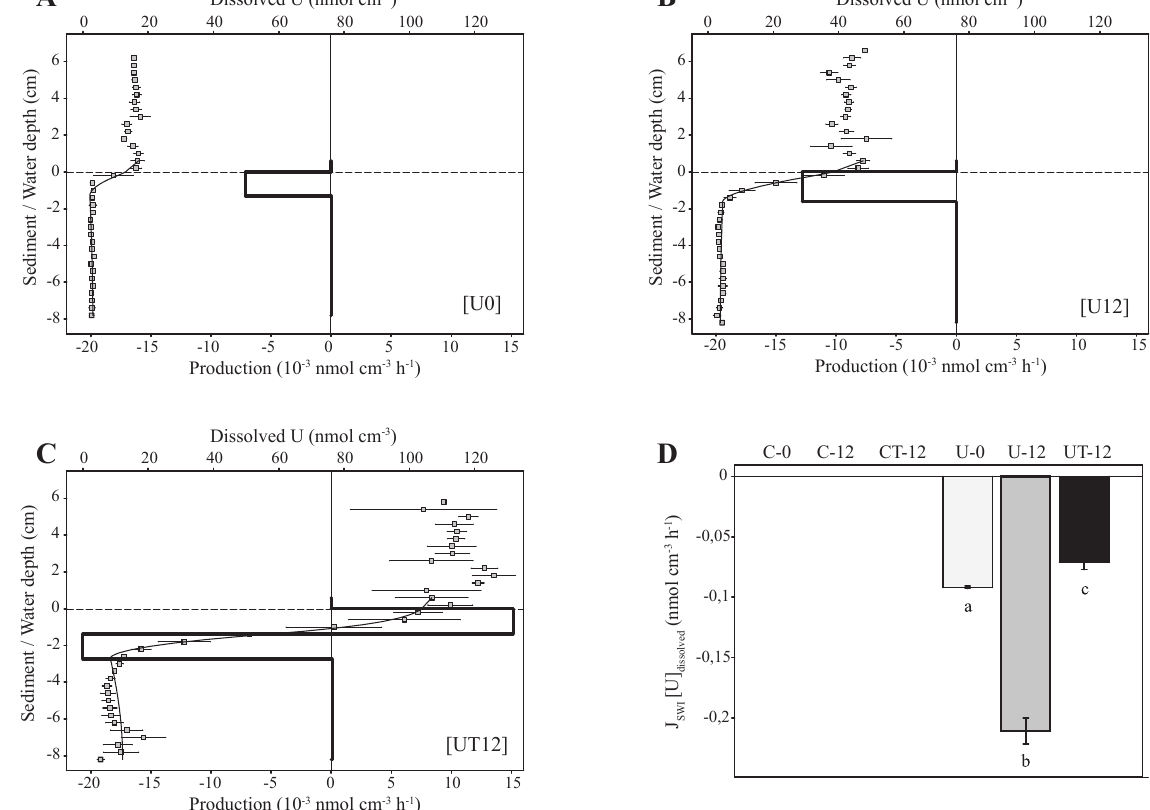
Figure 2. ( A–C ) Dissolved U concentration profiles and instantaneous consumption/production rates in the sediment estimated in the dif- ferent treatments (at initial conditions [U-0], and after 12 days without [U-12] or with [UT-12] T. tubifex worms in the sediment) using PROFILE software. Grey dots are measured concentrations (means ± SD, N = 3) and the fine black line the fitted concentration profile. The bold black line shows the production as a function of depth modelled from the concentration profile. The dotted line indicates the sediment– water interface. ( D ) Diffusive downward fluxes (integrated with the height of overlying water) of dissolved U in the different treatments estimated from concentration profiles. Means ± SD ( N = 3). Different letters correspond to significant differences between treatments. The data corresponding to control (i.e. uncontaminated) treatments – [C-O], [C-12] and [CT-12] – are not plotted (concentrations below the detection